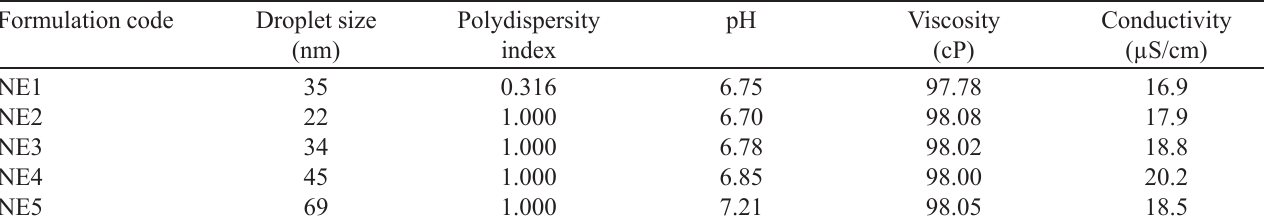
TABLE IV - Physicochemical parameter of the various nanoemulsions Formulation code